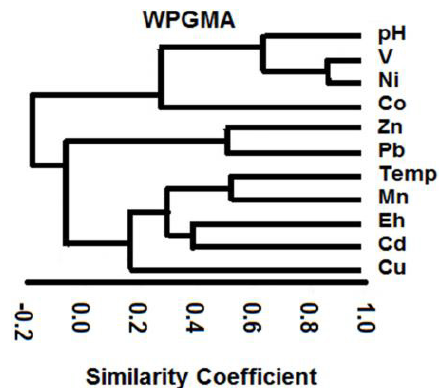
Fig. 2: Cluster analysis of elements in the Persian Gulf water 52 µg/L in station 2. Mn concentration varies from 63 µg/L in station 4 to 89 µg/L in station 5.